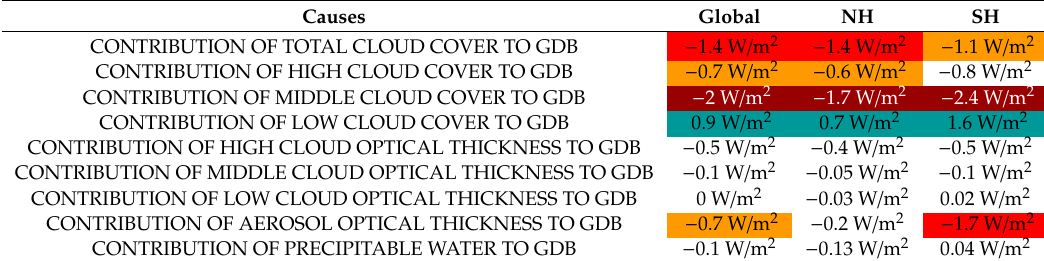
Table 2. Contribution (in W / m 2 ) of changes in the main drivers of surface solar radiation to the changes of downward surface solar radiation (DSR), i.e., GDB, during 2001–2009; the results are given separately for the two hemispheres and the globe (for the areal coverage of Figure 1). Colored cells indicate the largest contributions to GDB. Brown, red, and orange colors indicate the largest, second largest, and third largest contributions to dimming (negative values), respectively, and the cyan color corresponds to brightening (positive